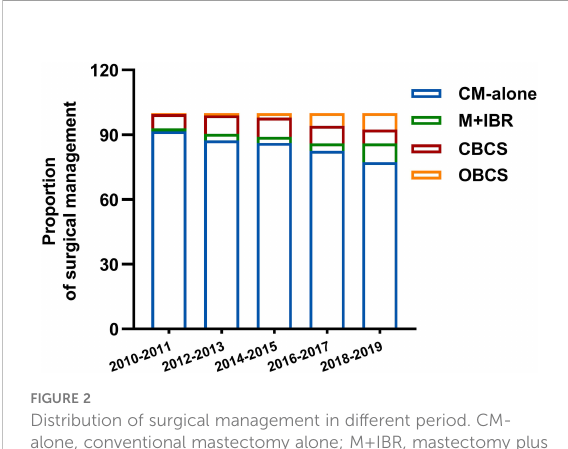
FIGURE 2 Distribution of surgical management in different period. CM- alone, conventional mastectomy alone; M+IBR, mastectomy plus immediate breast reconstruction; CBCS, conventional breast- conserving surgery; OBCS, oncoplastic breast-conserving